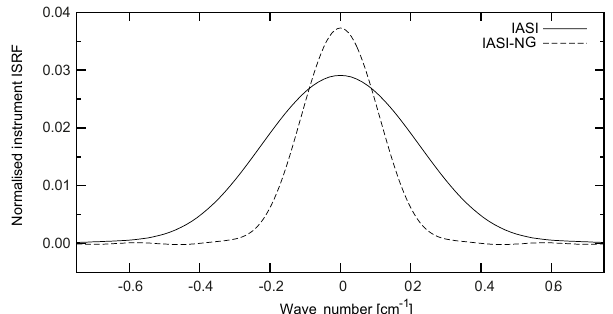
Figure 2. IASI and IASI-NG instrument spectral response functions (ISRFs). IASI-NG spectral resolution is double that of IASI thanks to the optical path increment providing thinner instrument